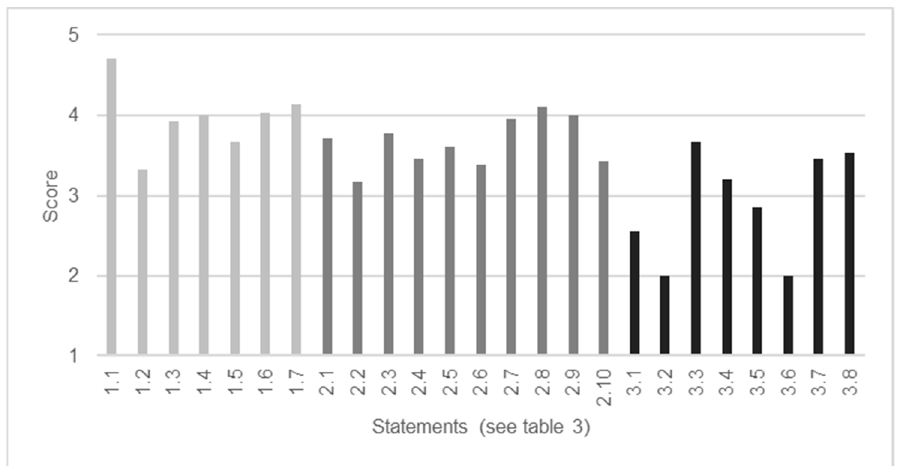
Figure 8. Average score per statement over all companies.